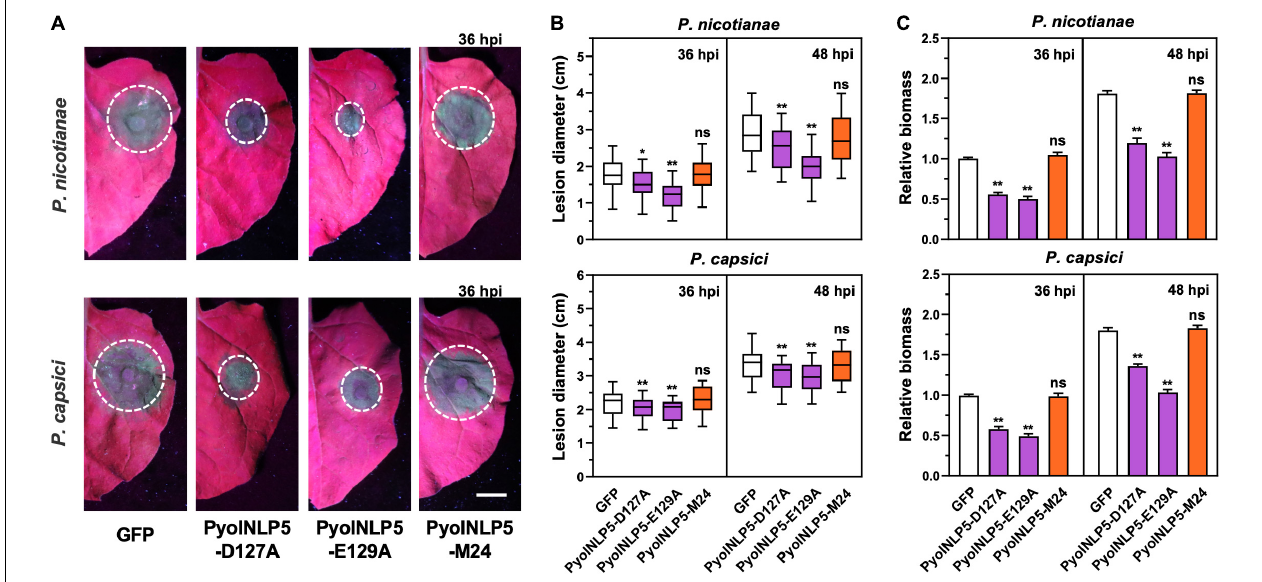
FIGURE 2 | PyolNLP5-mediated plant disease resistance is independent of its necrosis-inducing activity. (A) Infection phenotypes of agroinfiltrated N. benthamiana leaves expressing GFP, PyolNLP5-D127A, PyolNLP5-E129A or PyolNLP5-M24, and followed by the inoculation of P. nicotianae isolate 025 or P. capsici isolate LT263. Photos were taken at 36 hpi (Scale bar, 1 cm). GFP was used as a negative control. (B) Lesion diameters were measured using ImageJ. Data were analyzed from 40 biological replicates. Error bar represents mean ± SD. (C) Relative biomass was determined by quantitative polymerase chain reaction (qPCR). Expression levels of P. capsici and P. nicotianae Actin were determined by qPCR using N. benthamiana EF1 α as reference. Error bar represents mean ± SD ( n = 3). Data were analyzed by Median-edition Levene’s test to determine the homogeneity of variance across groups, and then analyzed by one-way ANOVA with post-hoc Tukey’s